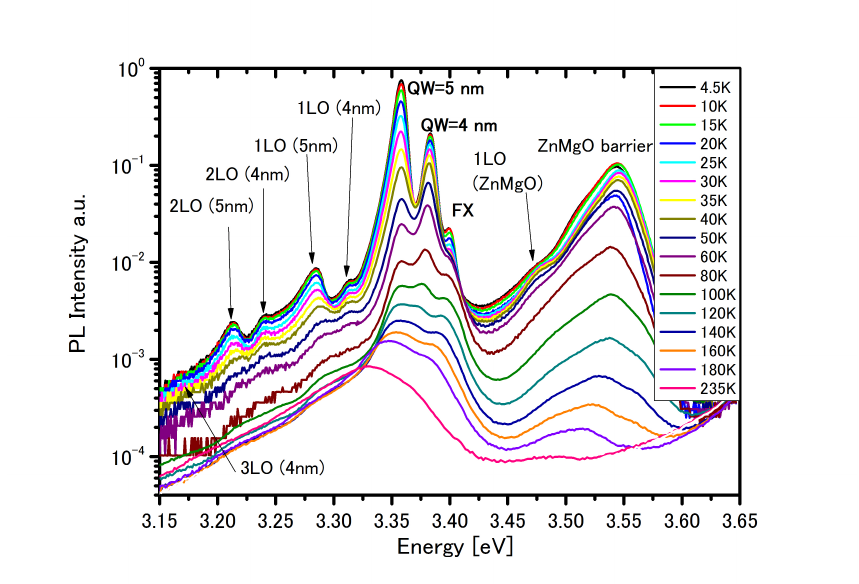
Figure 1. PL spectra at different temperature for structure